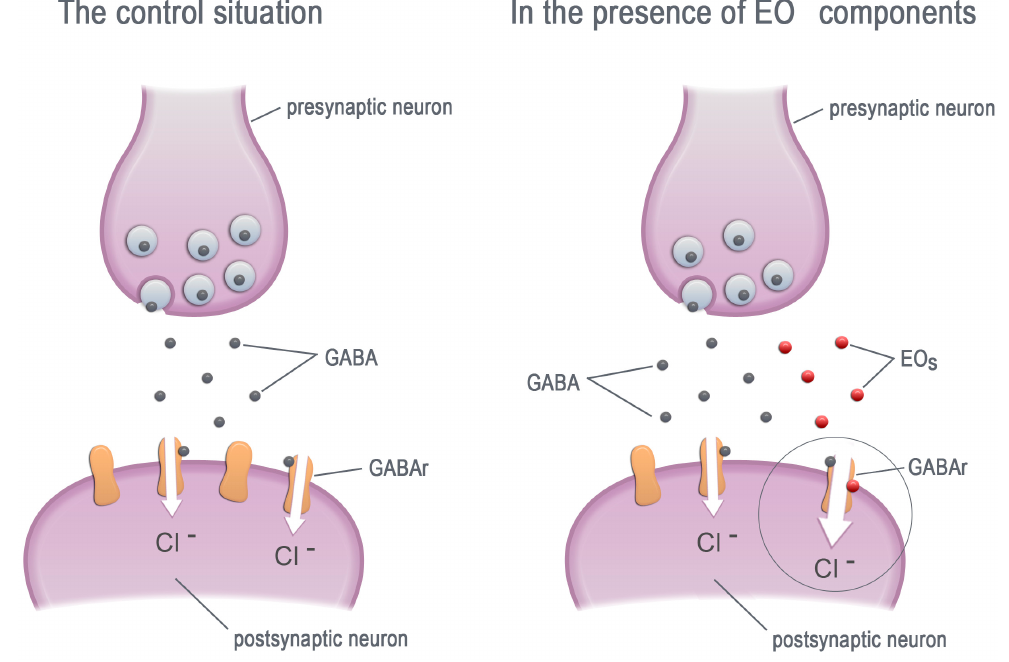
Figure 2. The EO components increase the chloride current by allosteric modulation of the GABA receptors. GABA— γ -aminobutyric acid, GABAr—GABA receptors, EOs—essential oil